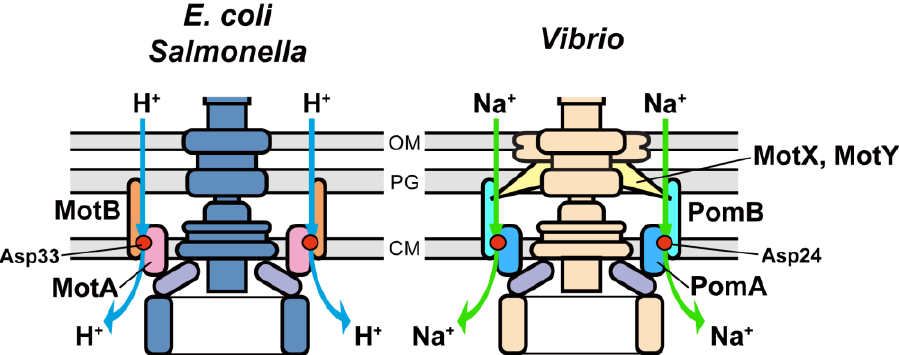
Figure 3. Schematic diagrams of the bacterial H + -driven and Na + -driven flagellar motors. E. coli and Salmonella have the H + -driven flagellar motor (left) whereas Vibrio alginolyticus has the Na + -driven polar flagellar motor (right). The stator of the flagellar motor consists of MotA and MotB in the H + -driven motor and of PomA and PomB in the Na + -driven motor. MotX and MotY are required for efficient assembly of the PomA/B complex around the motor in Vibrio .